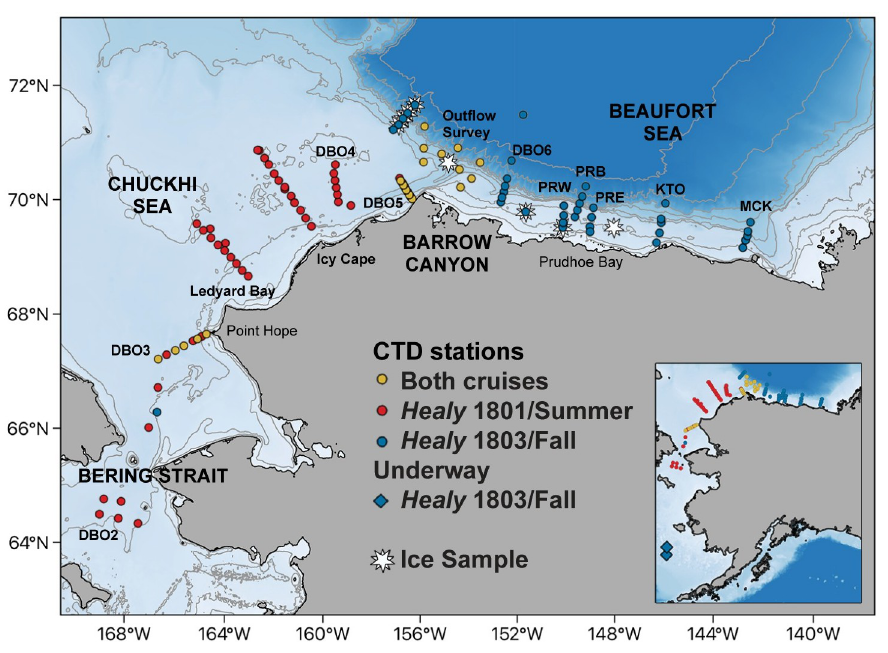
Fig 1. Station map. Locations of stations sampled during summer ( Healy 1801; red circles), fall ( Healy 1803; blue circles), or both cruises (yellow circles). Underway stations sampled (blue diamonds) and sea ice samples (white stars) were collected on the fall Healy 1803 cruise. Major circulation pathways are highlighted separately